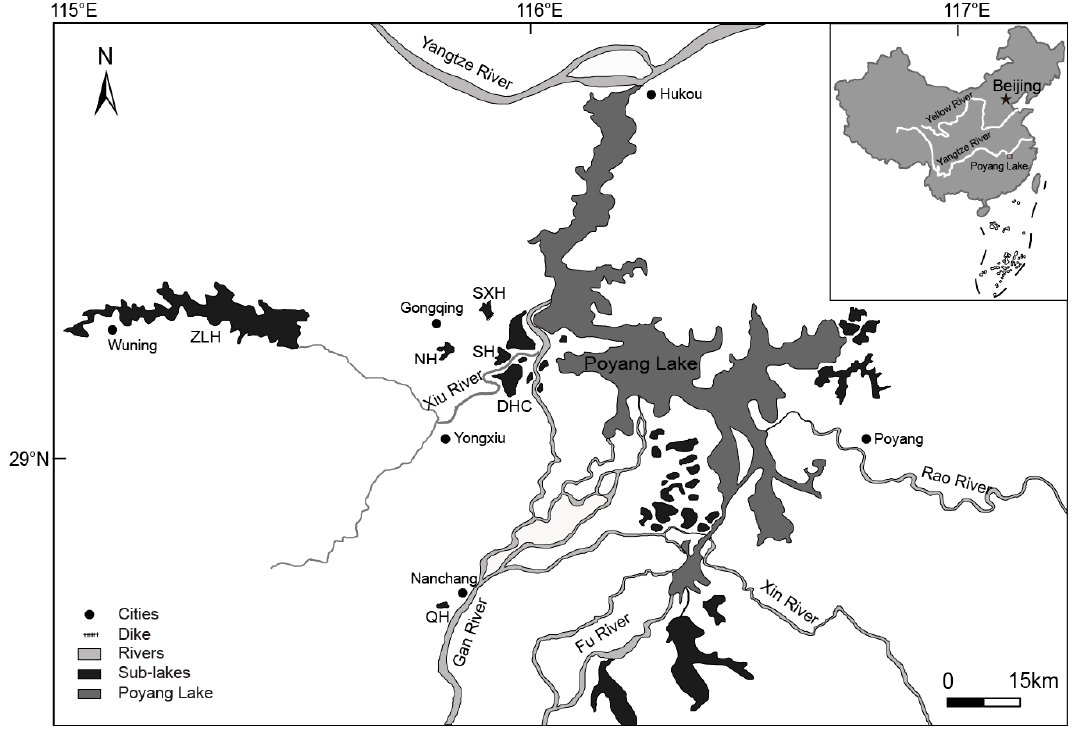
Figure 1. Distribution of Poyang Lake, sub-lakes and associated rivers in China.